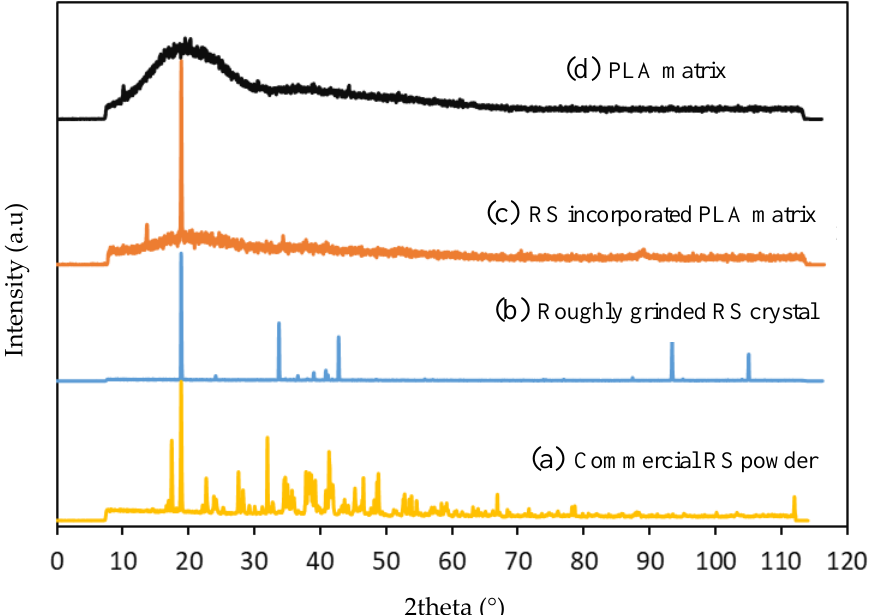
Figure 2. Comparative XRD diffractogram performed on ( a ) PLA matrix, ( b ) RS-incorporated PLA matrix, ( c ) roughly grinded single RS crystal, ( d ) commercial RS powder (provided by APC pure).